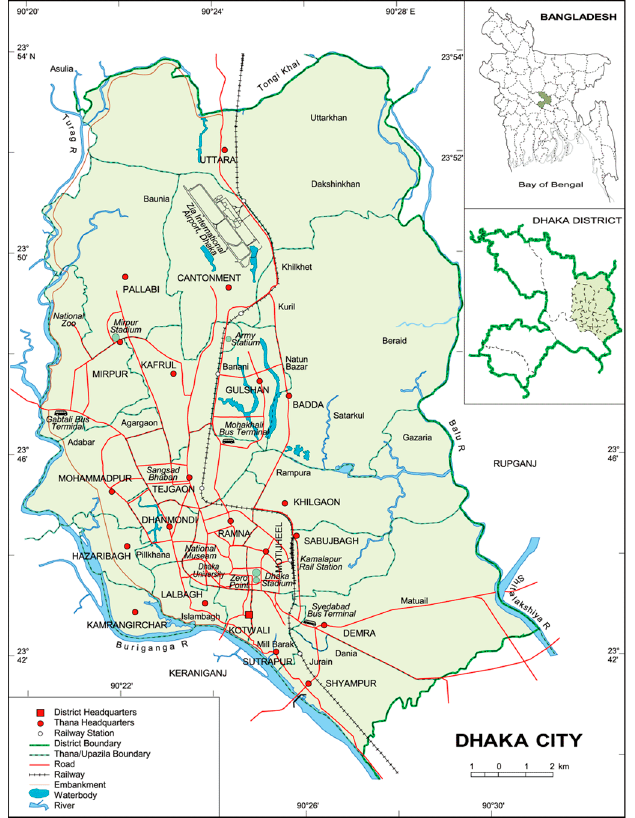
Figure 1. Location and administrative map of Dhaka city [13].